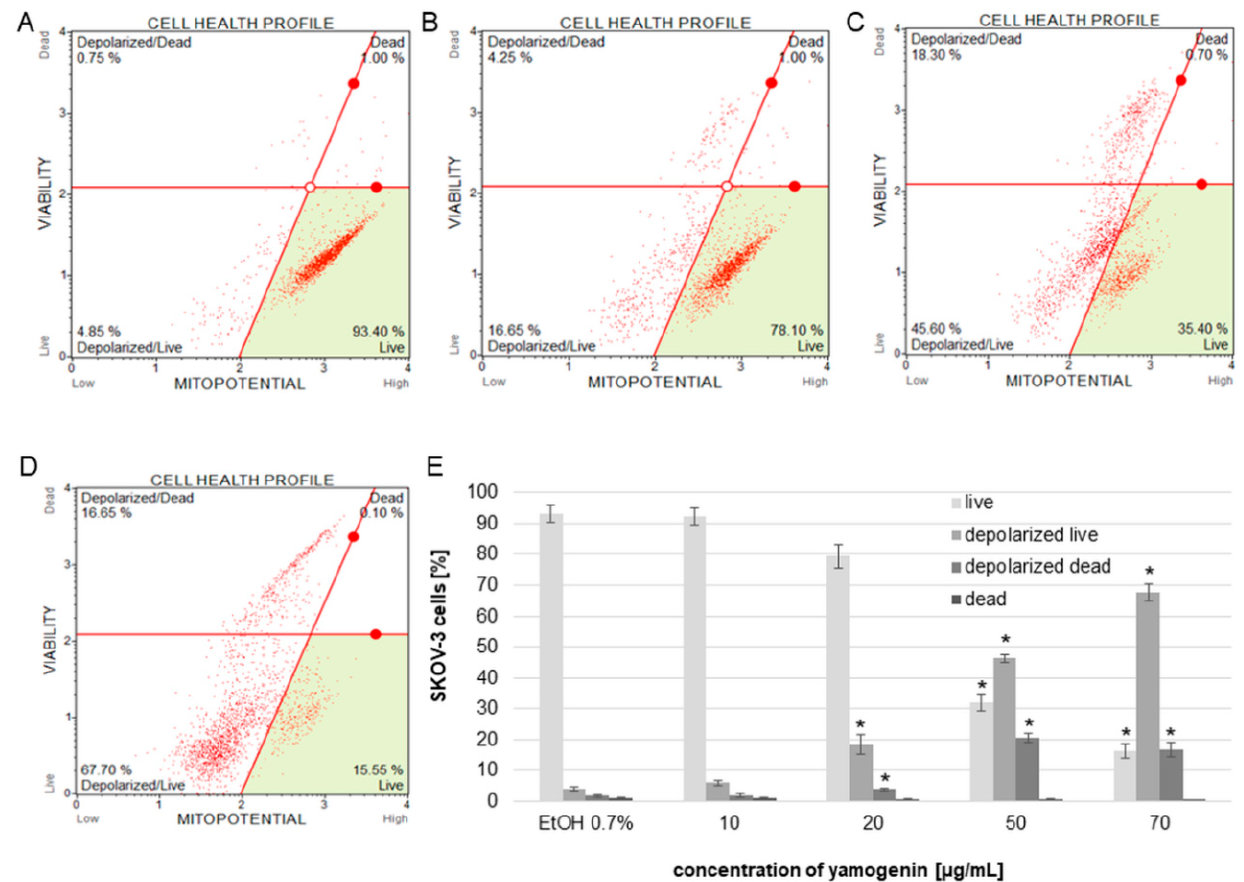
Figure 6. The changes in MMP of SKOV-3 treated with yamogenin for 24 h. The cells were incubated with ethanol (0.7% ( v/v )—a control, ( A )) and yamogenin concentrations of 10, 20 ( B ), 50 ( C ), and 70 µg/mL ( D ), respectively. The amount of live and dead depolarized cells was obtained with flow cytometry and is presented as percentage of the cells in the treated population ( E ). The values represent the means ± SD of three independent experiments. Error bars represent standard deviations. Significant differences relative to the control are marked with an asterisk (the Student’s t -test, * p < 0.05).